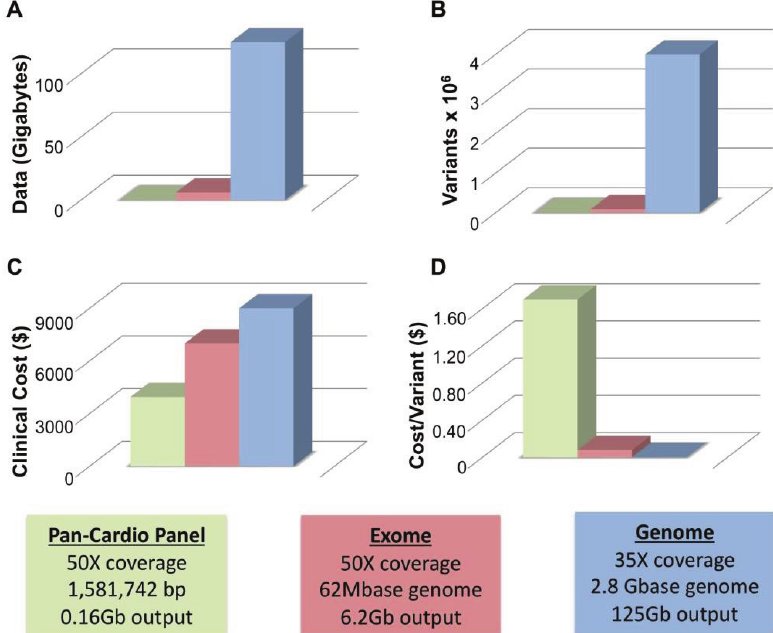
Figure 1. Size and Cost Considerations of Next-Generation Sequencing. ( A ) The amount of data generated by a typical cardiomyopathy gene panel of ~50 genes (green), whole exome sequencing (red) and whole genome Sequencing (blue) is shown; ( B ) The approximate number of variants produced by each method is indicated; ( C ) The Clinical cost of each method ranges from ~$4000 (cardiomyopathy gene panel, green) to ~$9500 (whole genome sequencing, blue); ( D ) The cost per variant is greatly reduced for WGS ($0.002, blue) versus WES ($0.08, red) and gene panel-based sequencing ($1.70, green). Boxes indicate parameters used to calculate values in A – D including coverage, base pairs interrogated and total